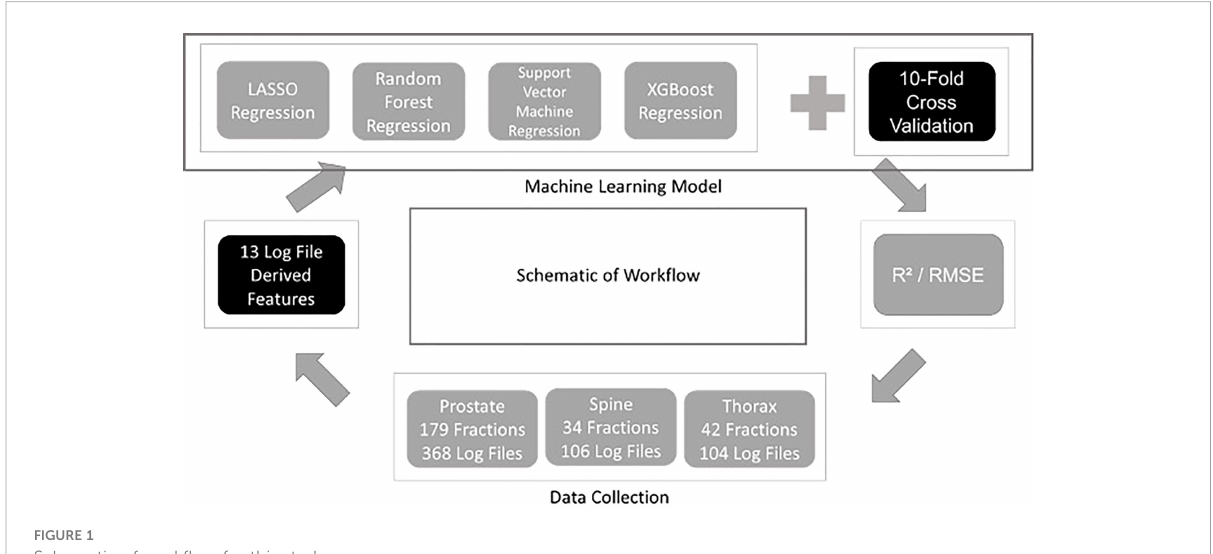
FIGURE 1 Schematic of work fl ow for this